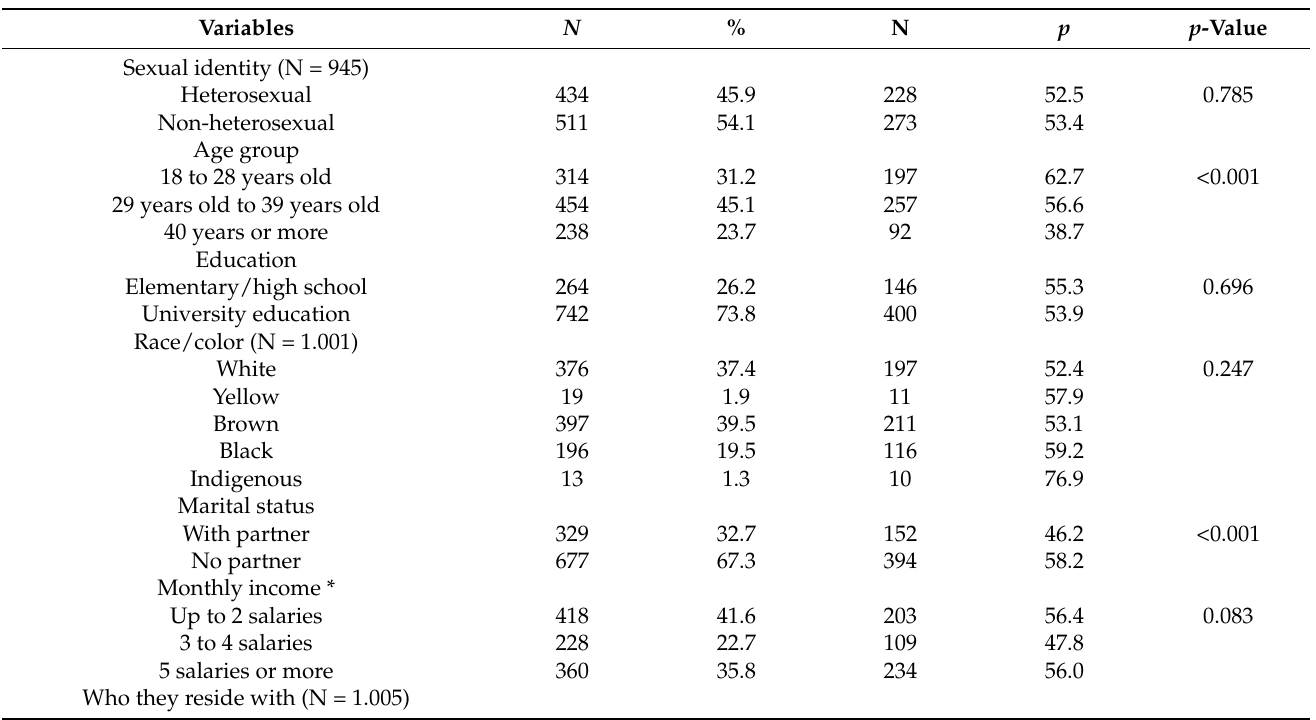
Table 1. Sociodemographic and occupational characteristics and prevalence of CMD in Brazilian men during the COVID-19 pandemic. Brazil, 2020. (N =